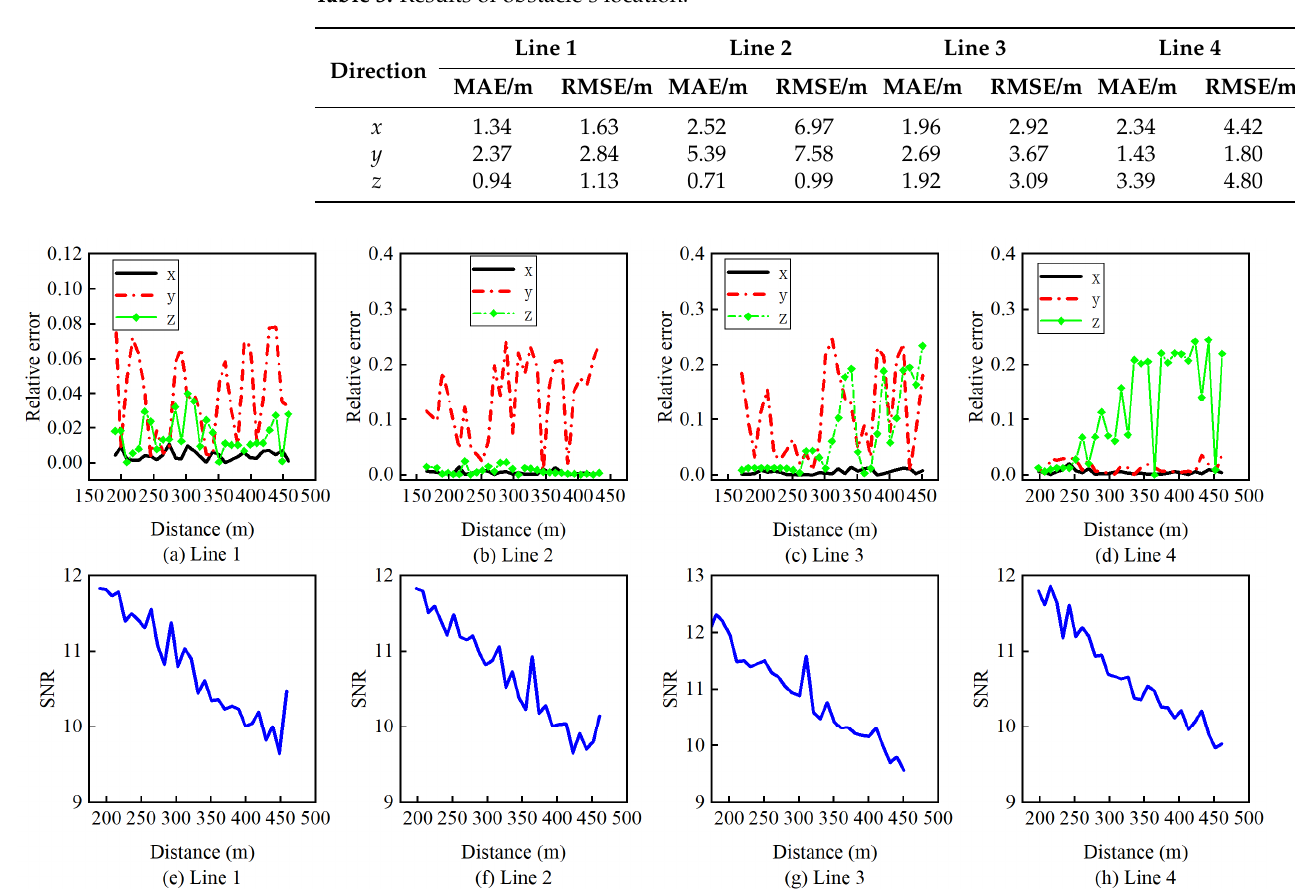
Figure 9. Variation in ER and SNR with distance.